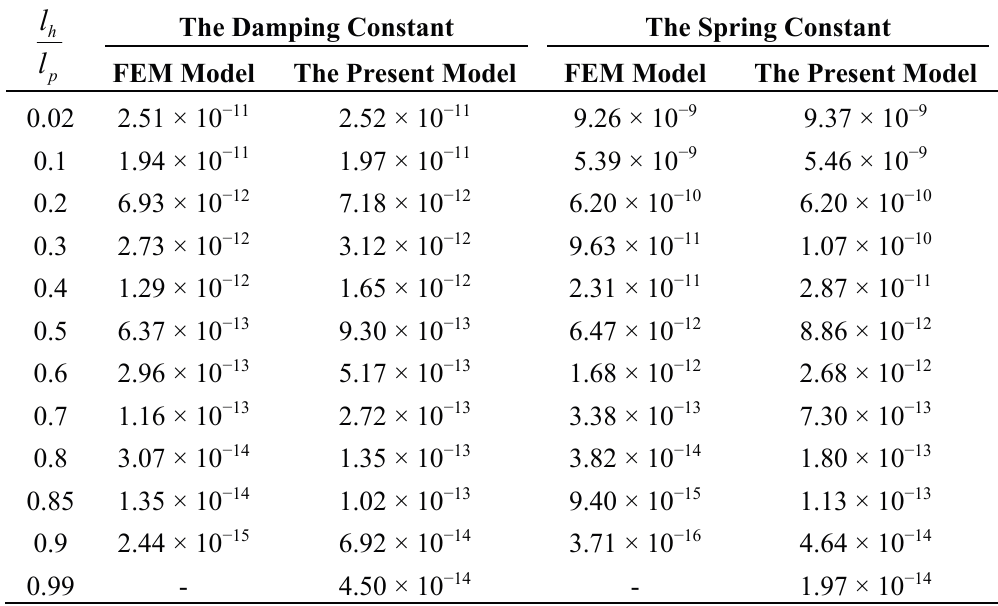
Figure 7. Comparison of the spring constant of the type I devices obtained by the FEM model and the present model. Table 4. The damping and spring constants obtained by the ANSYS model and the presnt model for the torsion microplate (Type